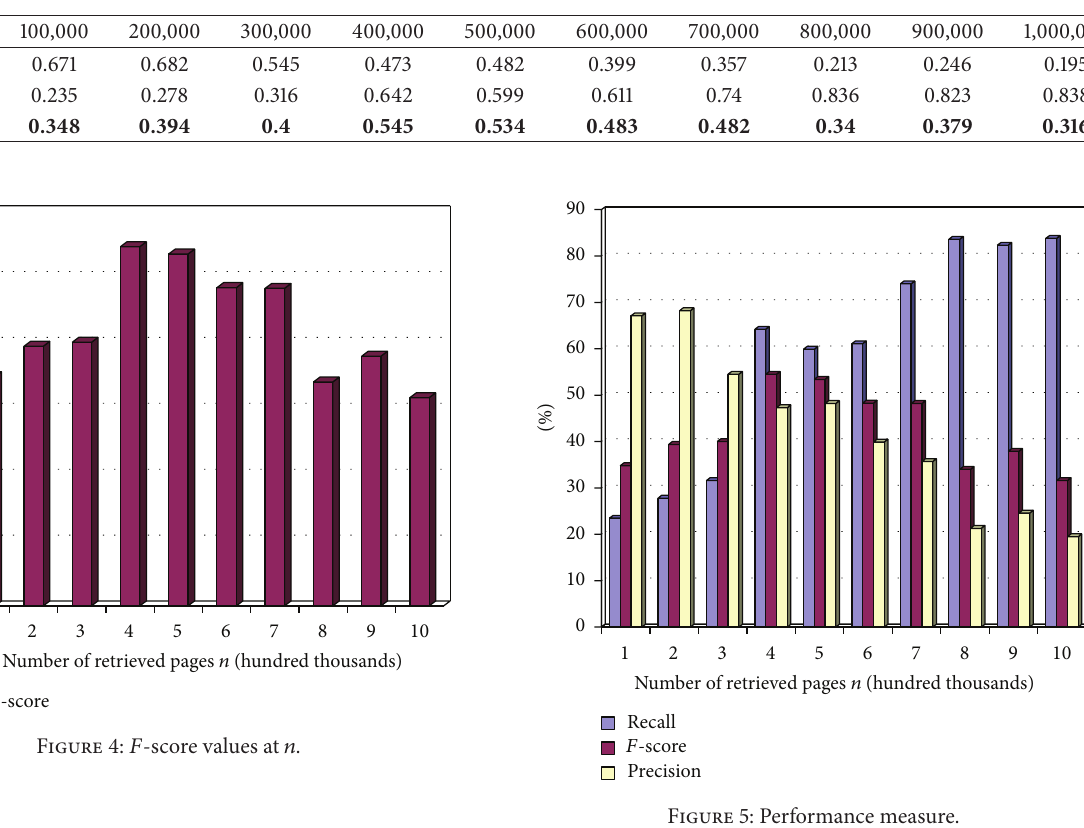
Table 2: Recall, precision, and 𝐹 -score values at 𝑛 .